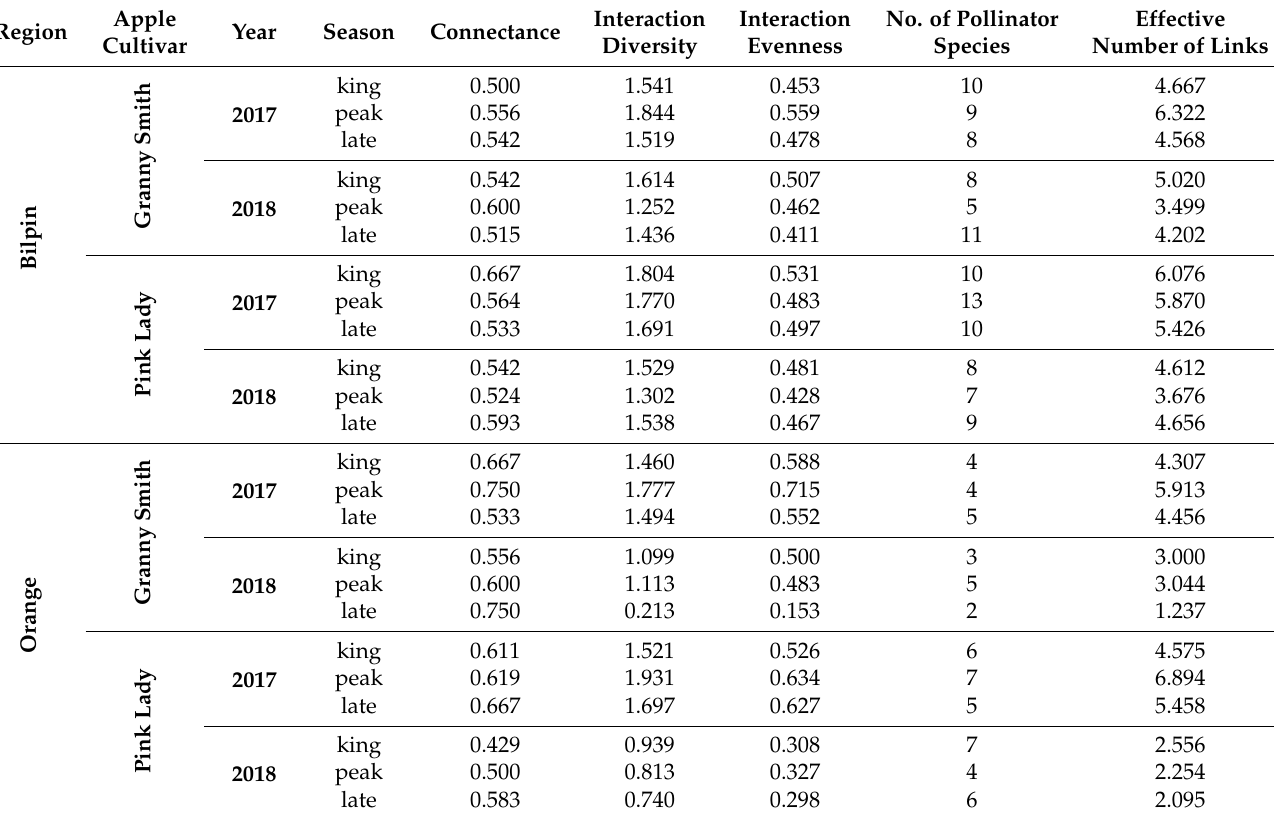
Table 2. Bipartite network indices based on observations of plant–pollinator interactions pooled across orchards by habitat type (within orchard, wider matrix and apple cultivar (Pink Lady or Granny Smith)) for two apple-growing regions, Bilpin and Orange, during king, peak and late apple bloom, in 2017 and 2018. The numbers of orchards differed by location and crop variety studied, with three (Bilpin) and two (Orange) orchards for Granny Smith and five (Bilpin) and four (Orange) orchards for Pink